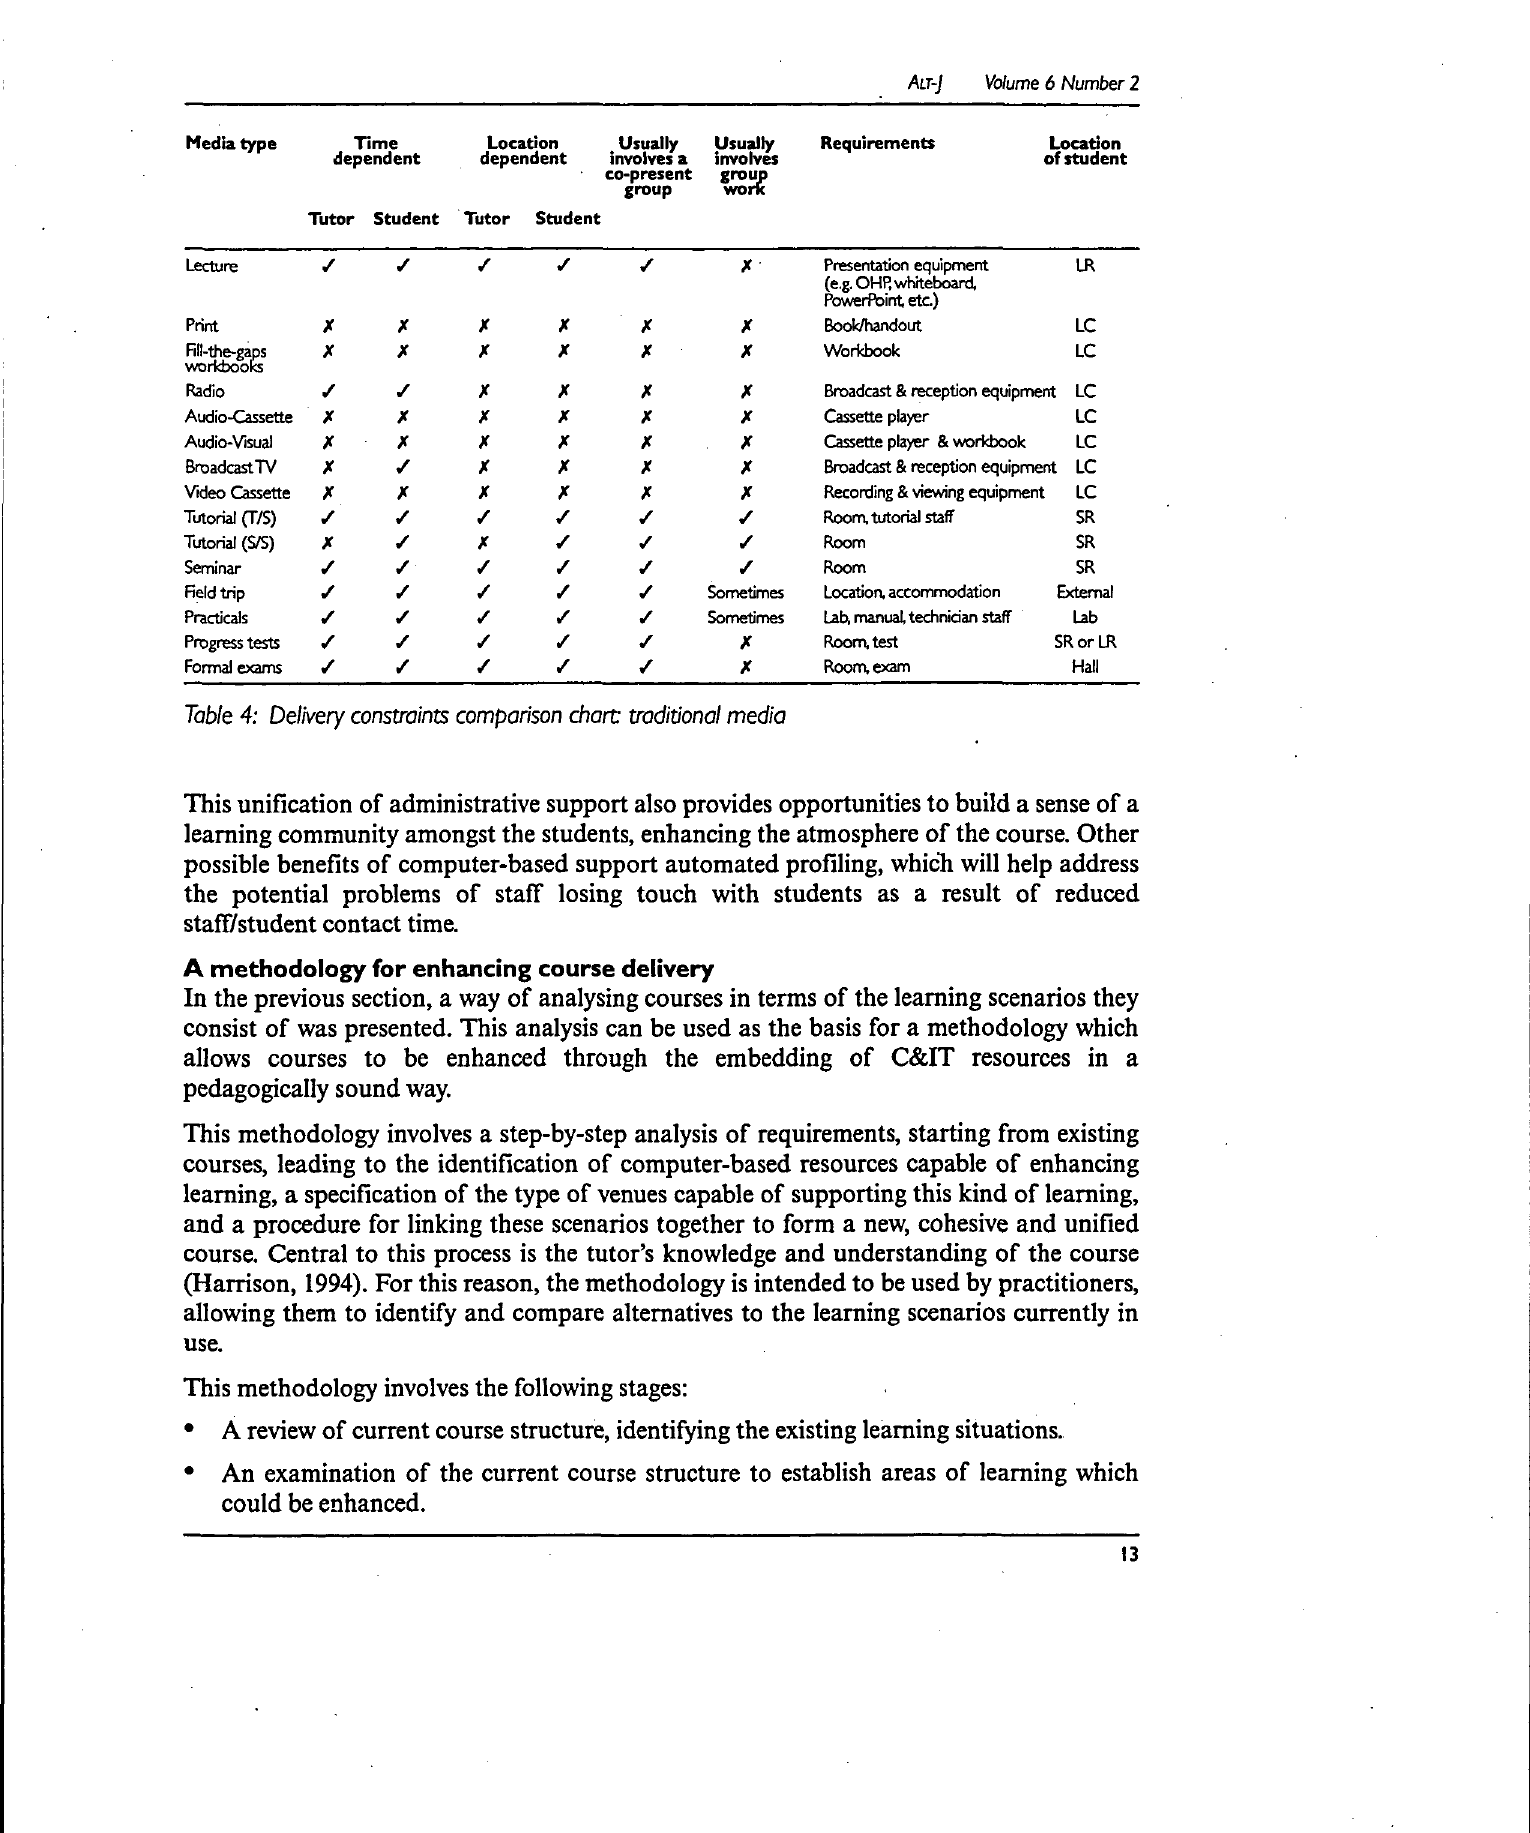
Table 4: Delivery constraints comparison chart traditional